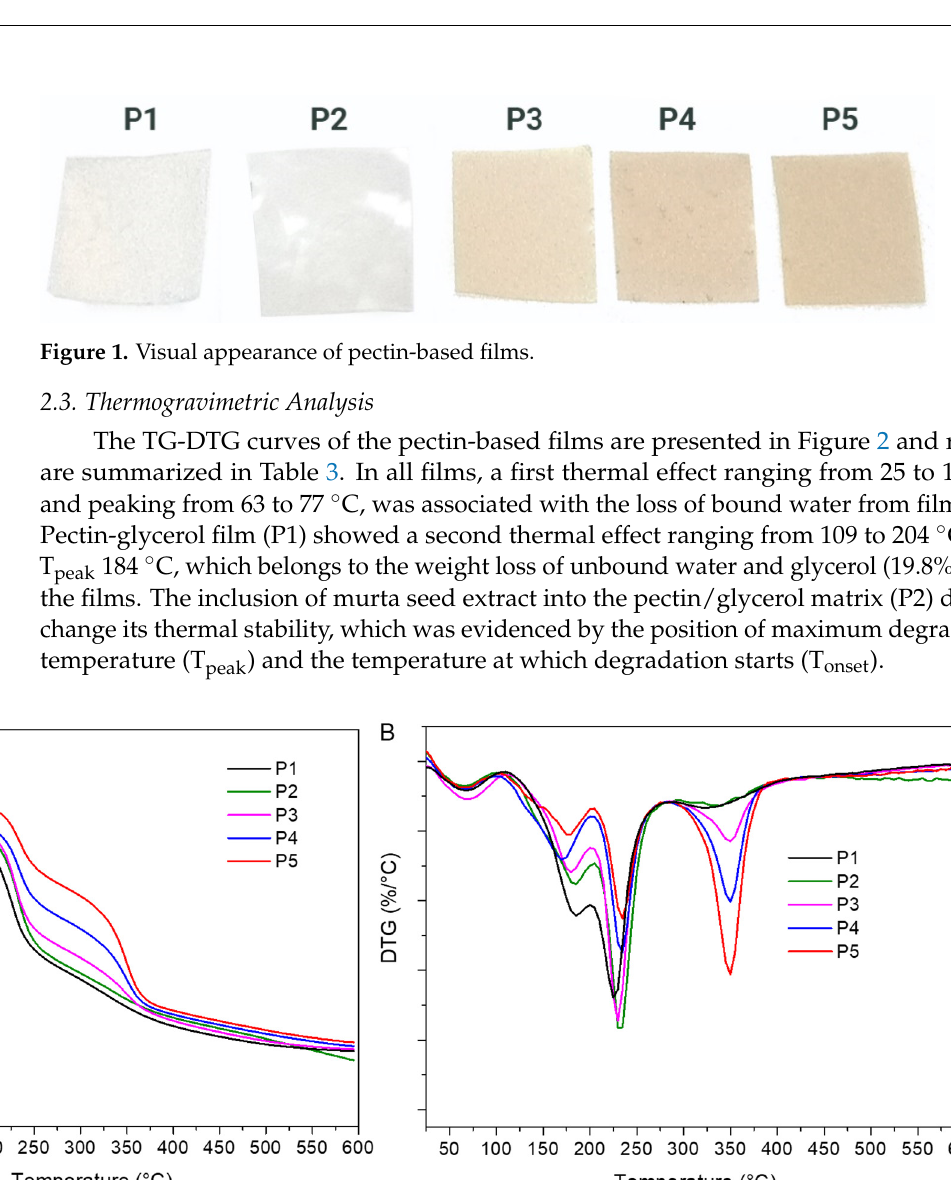
4 of 11 Figure 1. Visual appearance of pectin-based films.